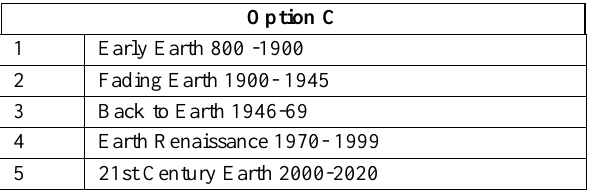
Table 3. Potential chronological primary structure